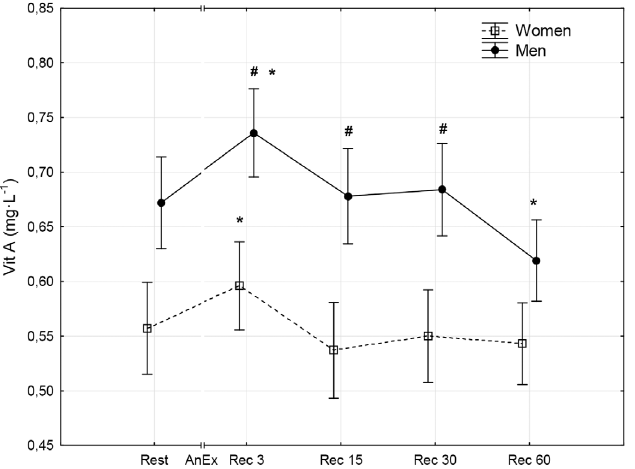
Fig 4. Concentration of vitamin A (Vit A) in blood plasma prior to (Rest) and 3 minutes (Rec 3), 15 minutes (Rec 15), 30 minutes (Rec 30) and 60 minutes (Rec 60) after anaerobic exercise (AnEx). Data are given as mean ± standard error; p < 0.05 statistically significant differences * between results obtained after anaerobic exercise (AnEx) and initial results (Rest); # between results obtained by men and